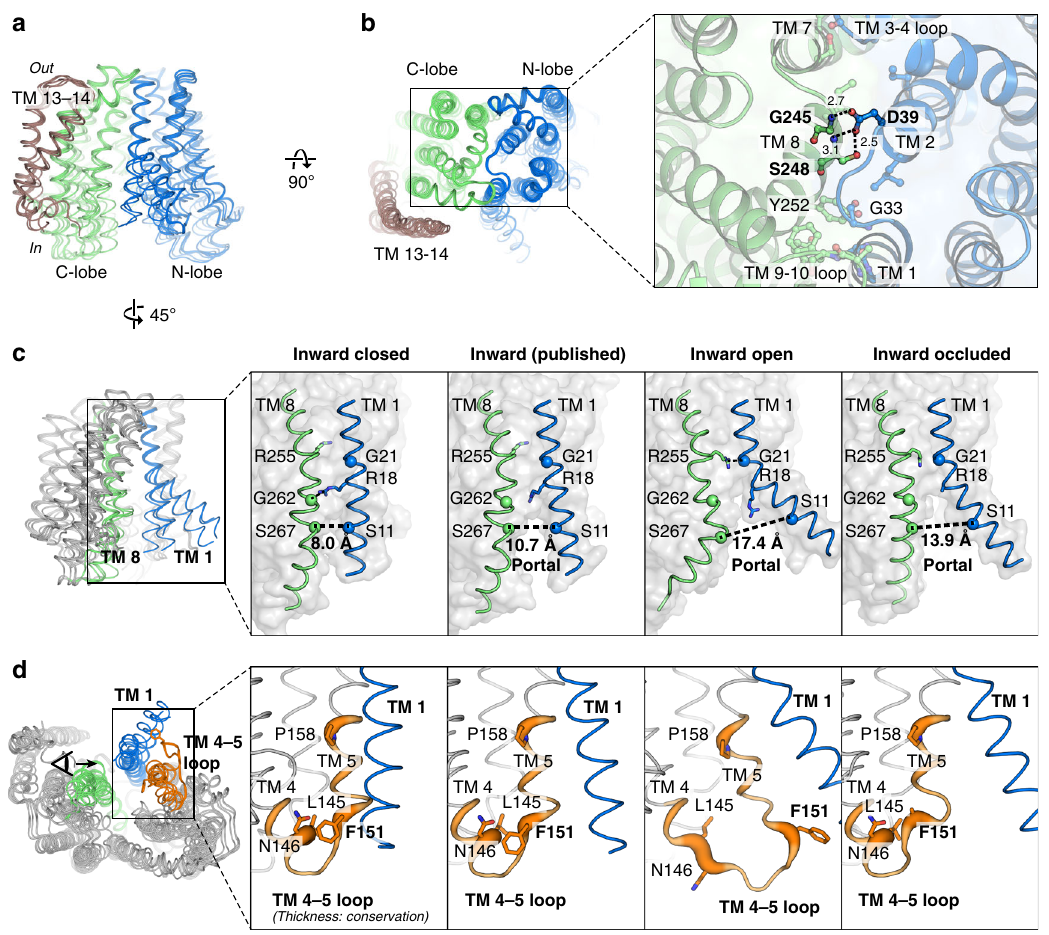
Fig. 2 Lateral gating mechanism in the inward-facing state. a Superposition of inward-facing structures highlights similarity at the periplasmic gate but divergence at the cytoplasmic gate. b The periplasmic gate is stabilized by hydrogen bonds between Gly245/Ser248 and the essential Asp39. c At the cytoplasmic side, coordinated rearrangement of TM 1 (blue) and TM 8 (green) controls portal dilation. The C α -C α distance between Ser11 (TM 1) and Ser267 (TM 8) increases from 8.0 Å in the inward-closed structure to 17.4 Å in the inward-open structure. d Rearrangement of the TM 4 – 5 loop (orange) and unwinding of the cytoplasmic ends of TMs 4/5 could induce bending of TM 1. The conserved Phe151 (Phe157 in MurJ EC ) provides leverage to bend TM 1 (residues 1 – 20) out into the membrane. TM 4 – 5 loop is shown in sausage representation, with thickness proportional to conservation. Sidechains of Arg18 and Phe151 were not resolved in the inward-occluded